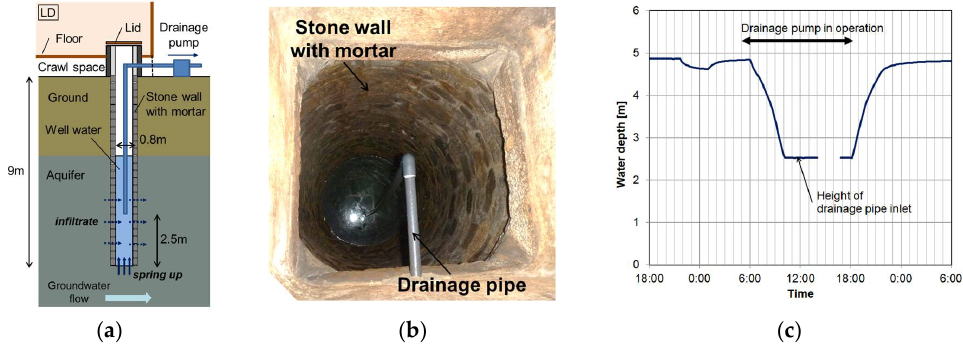
Figure 2. Information of the well: ( a ) schematic cross-section; ( b ) images of the well; and ( c ) change in the depth of water during the drainage-pump operation.